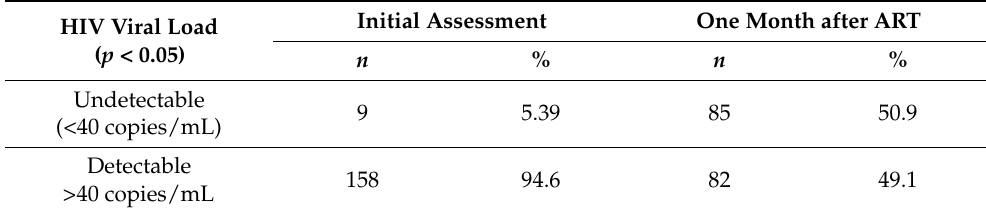
Table 11. Distribution by HIV viral load level, at initial assessment, and one month after